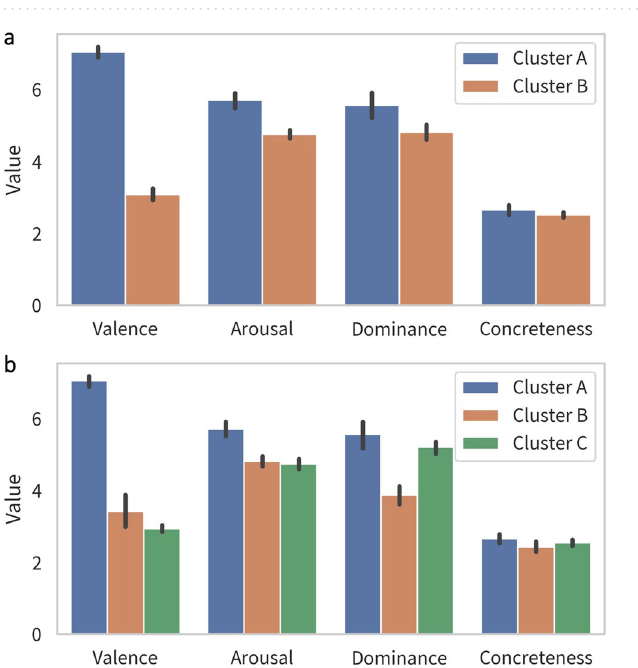
Figure 3. Descriptive profiles of each group in two-cluster and three-cluster solutions. ( a ) Group profile of two-cluster solution. Cluster A is positive and Cluster B is negative. ( b ) Group profile of three-cluster solution. Cluster A is positive, Cluster B is influenced negative, and Cluster C is influential